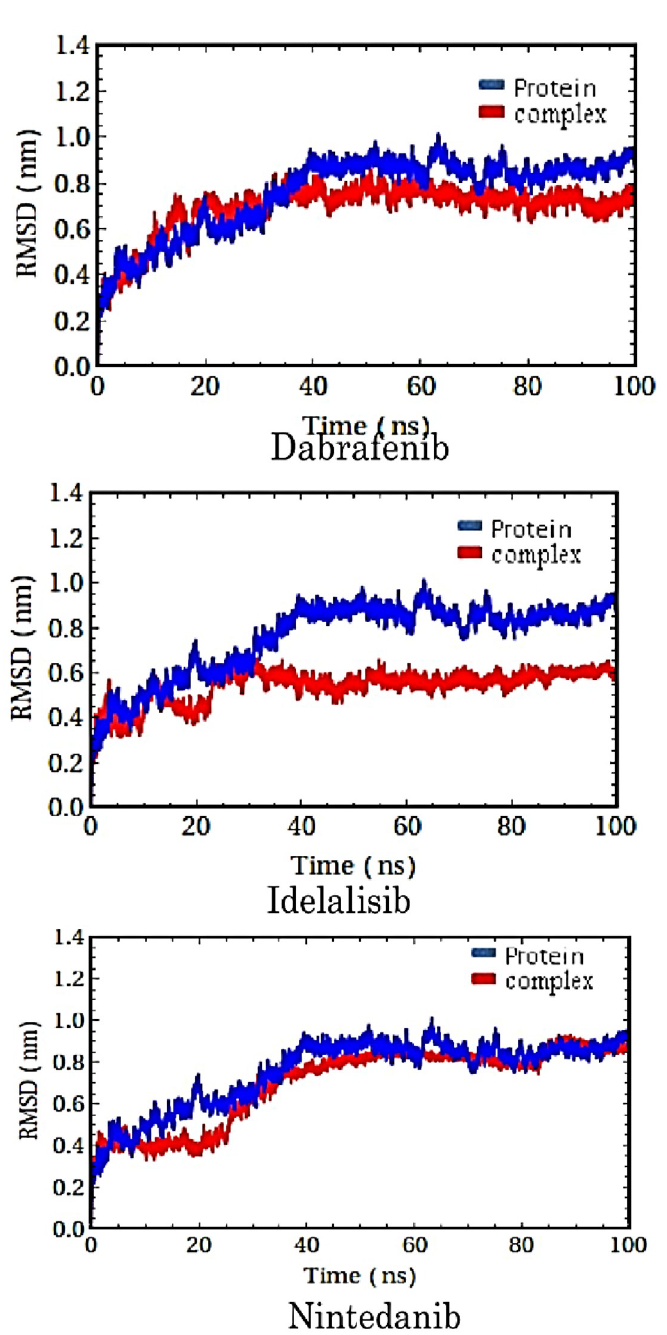
Fig 5. Overall structural changes in the type 1 dengue protease upon binding to the allosteric ligands. were calculated from the MD simulation trajectory. It was found that dabrafenib (Fig 7) did not form hydrogen bonds with the protein initially. However, after the molecular recognition occurred, it formed 3 hydrogen bonds indicating induced fit mode of binding. It is observed that idelalisib (Fig 7) can form one hydrogen bond by the end of simulation whereas 2 hydro- gen bonds are formed in the early period of simulation. Nintedanib was found to form as